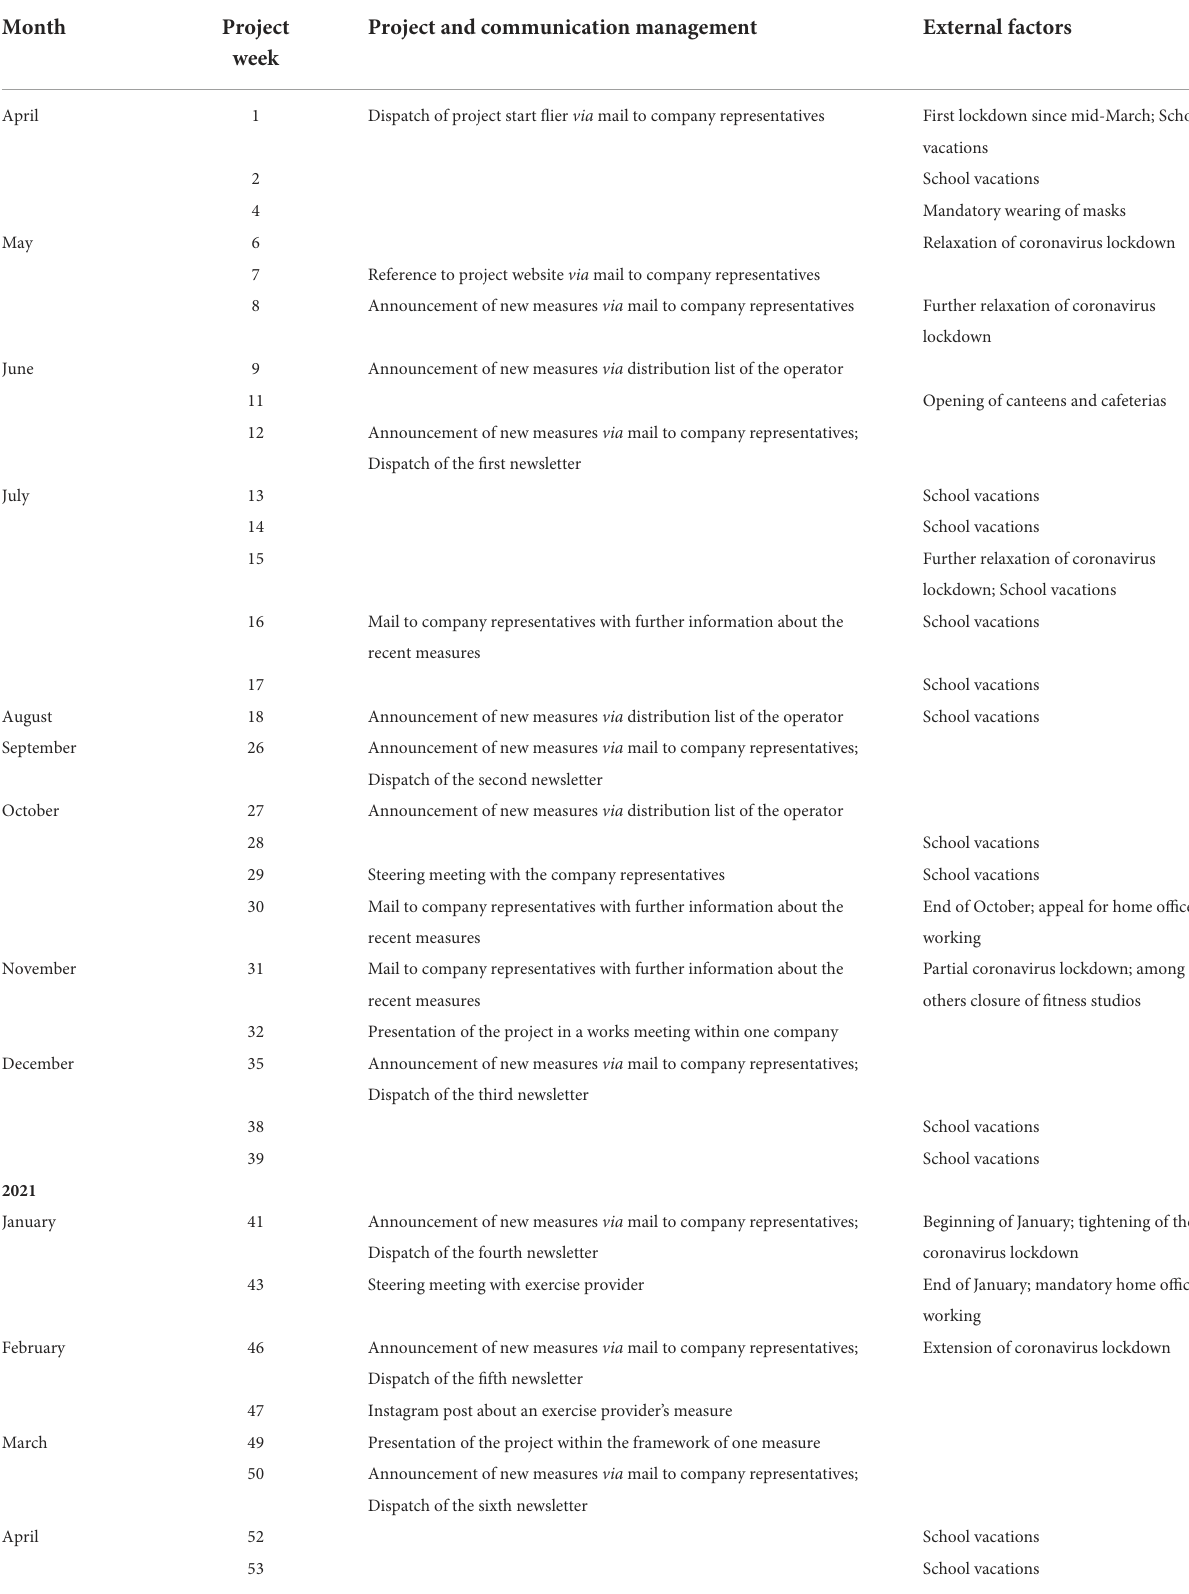
TABLE 3 Project and communication management and external factors in the course of the